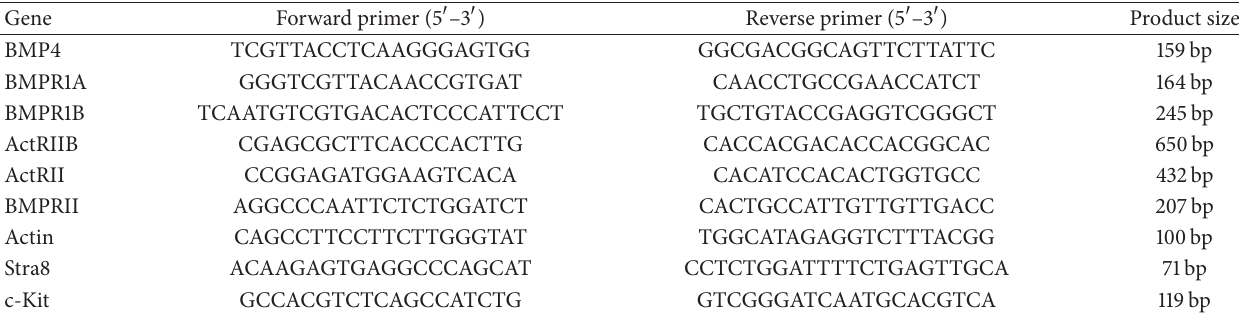
Table 1: PCR primer sequences and product